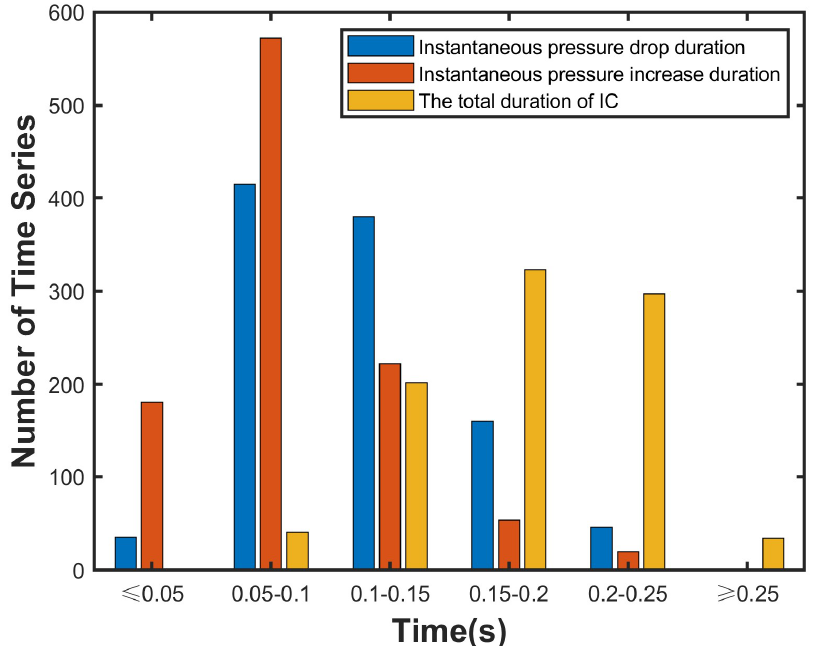
Figure 4. Statistical distribution of the total duration of IC.